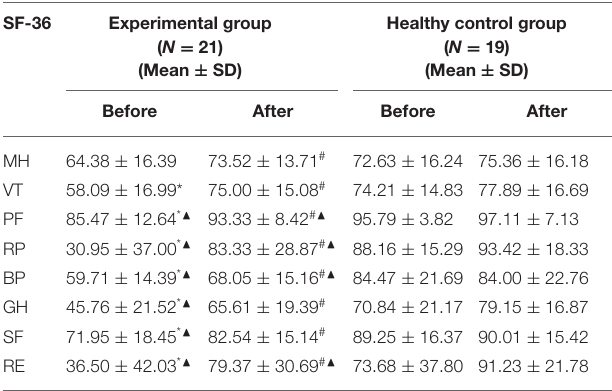
TABLE 2 | Comparison of SF-36 scores between the experimental group and the healthy control group before and after Tai Chi Chuan exercise.